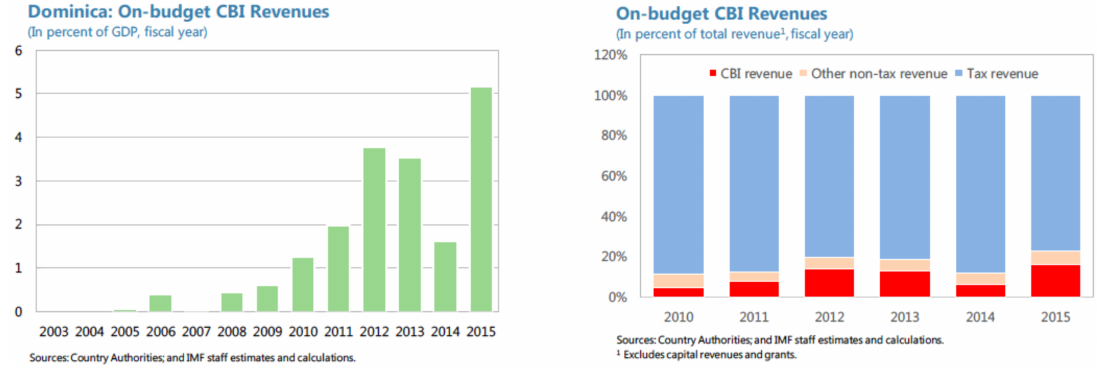
Figure 2. Revenue from the commodified citizenship program. Source: IMF country report, April